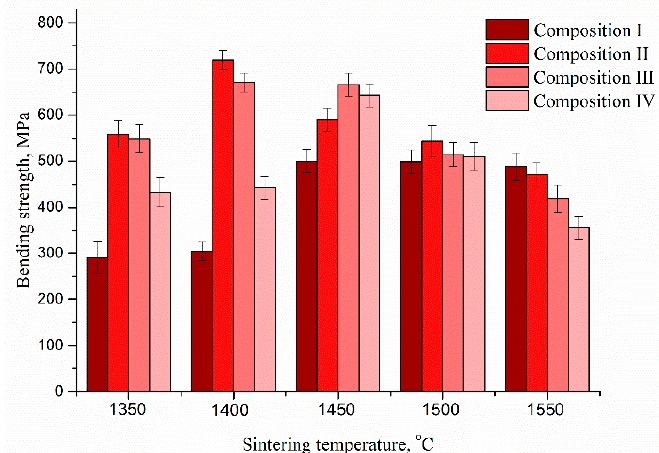
Figure 11. Bending strength of 3Y-TZP-Al 2 O 3 ceramics depending on sintering temperature and composition.